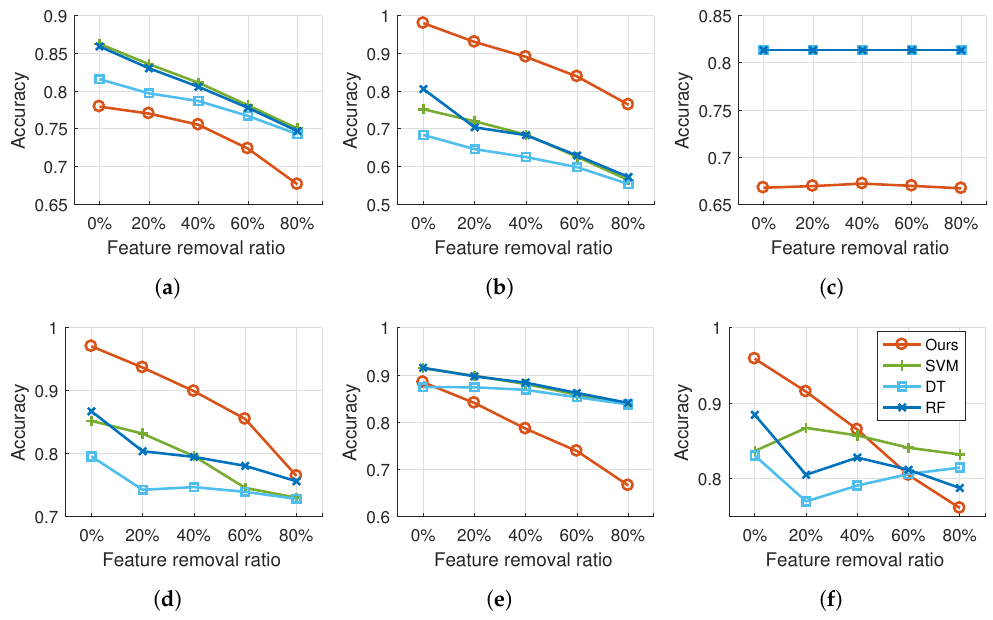
Figure 7. Performance results of the proposed model and comparison methods evaluated by accuracy for the second set of experiments. ( a ) Experiment 2s (Acc). ( b ) Experiment 3s (Acc). ( c ) Experiment 4s (Acc). ( d ) Experiment 5s (Acc). ( e ) Experiment 6s (Acc). ( f ) Experiment 7s (Acc).